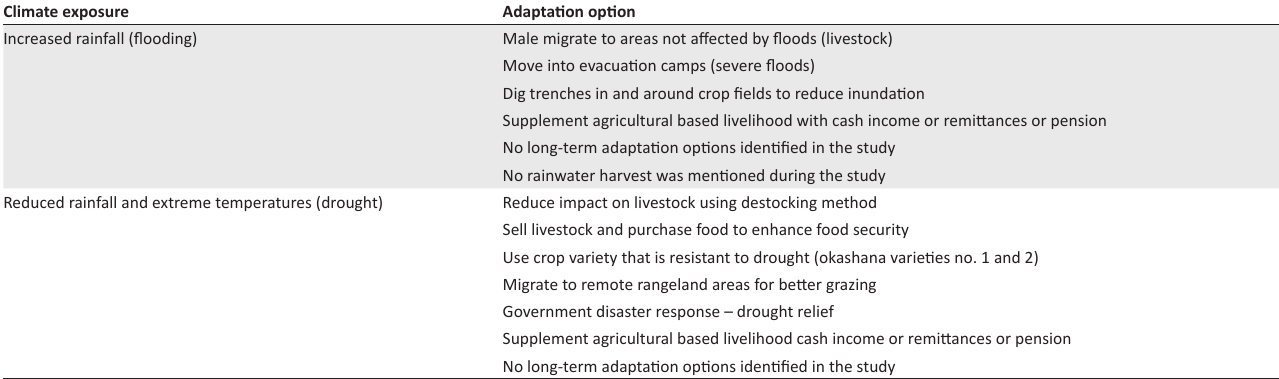
TABLE 5: Existing adaptation options in North-Central Namibia. Climate exposure Adaptation option Increased rainfall